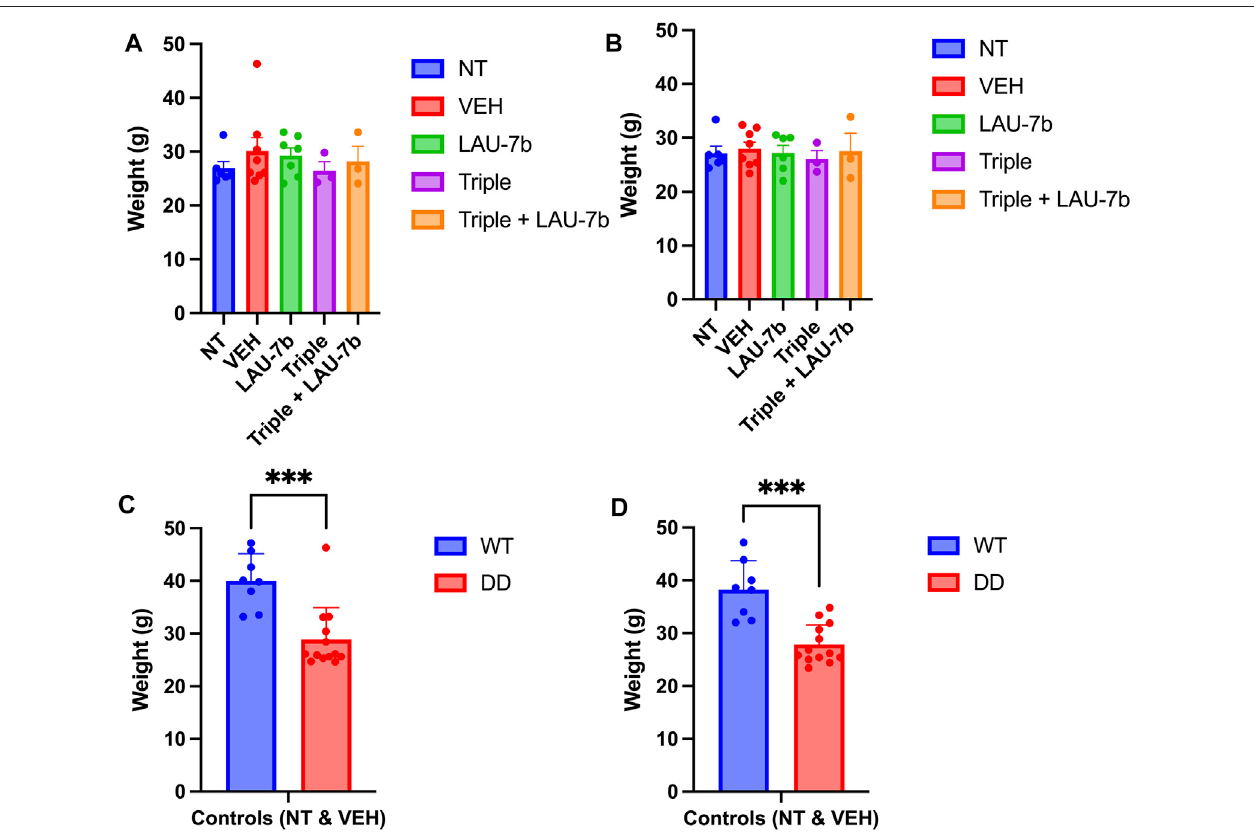
FIGURE 2 | Mice weights prior to (Day 0) and following 14-day treatment (Day 15) in Wild-type (WT) and F508del/F508del (DD) mice. (A,B) DD mice weights (g) beforetreatment(Day0)and24 hfollowing fi naltreatment(Day15)amongtreatmentgroups.Therewasnostatisticalsigni fi cancebetweenanyofthesegroups. n =3 – 12 miceforeachgroup. (C,D) ComparisonbetweenWTandDDmicecontrolswhichincludenon-treated(NT),orvehicletreated(VEH)mice. n =8 – 13miceforeachgroup. Welch ’ s t test was performed where p = 0.0003.